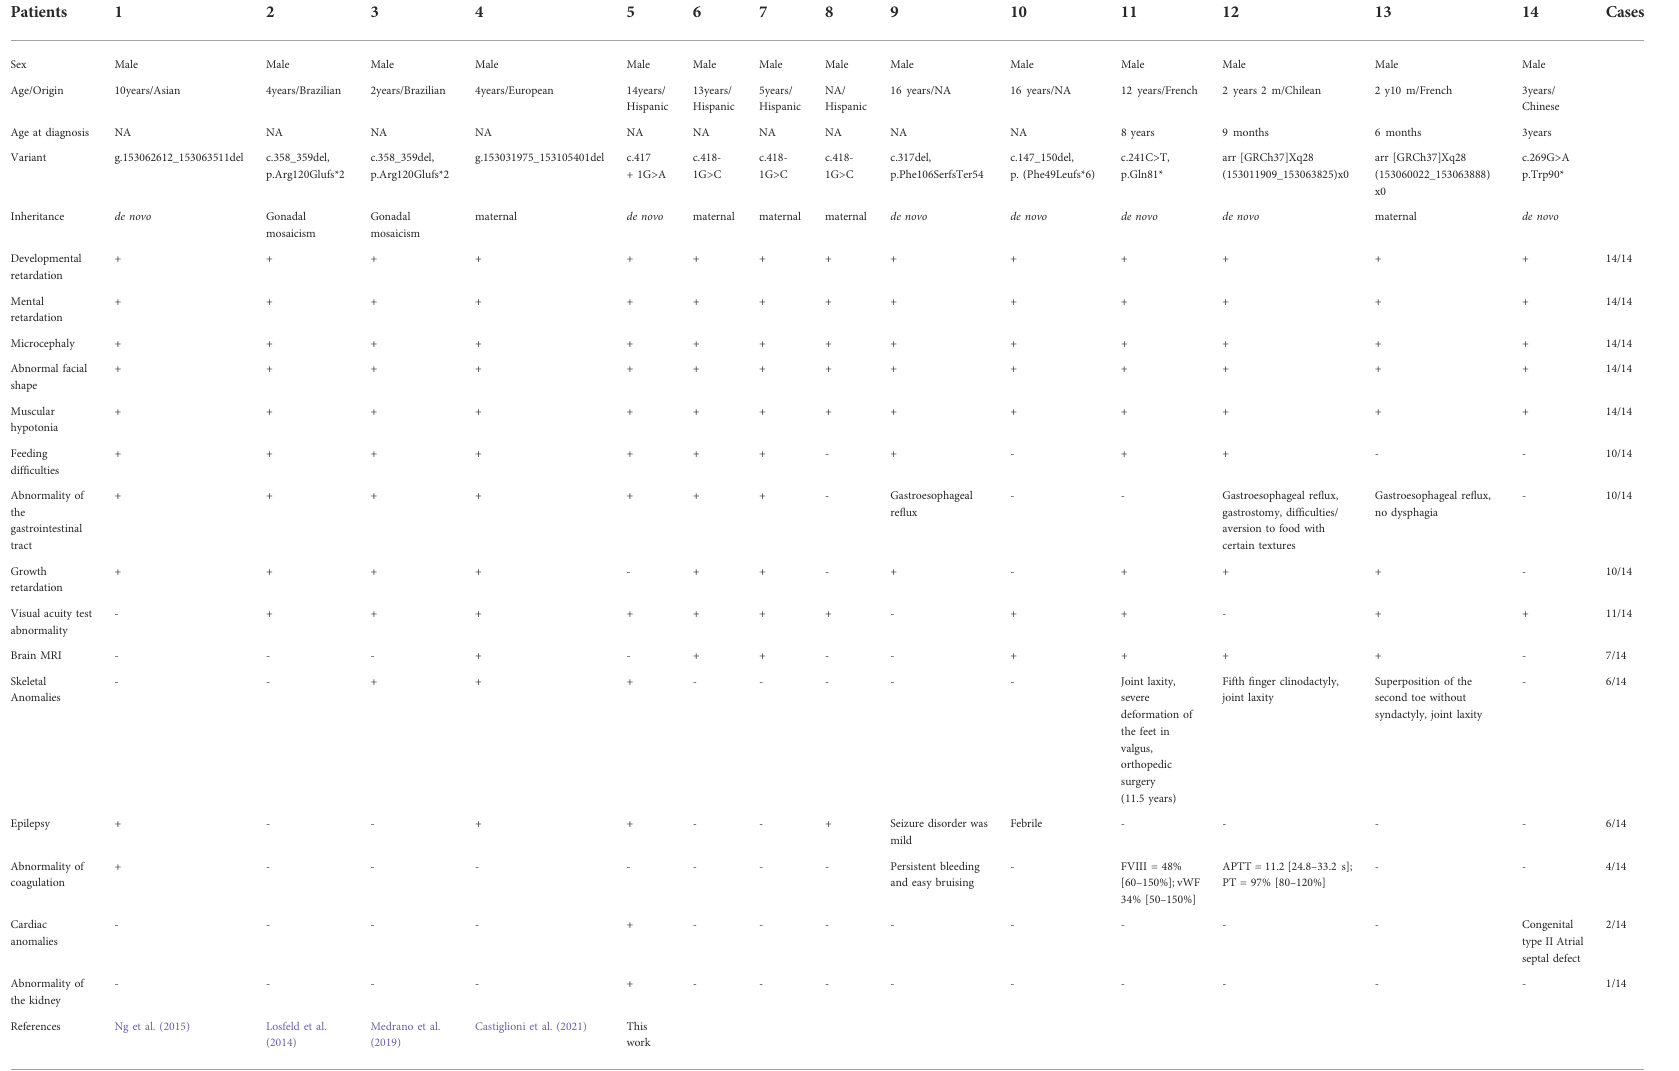
TABLE 1 The clinical fi ndings and the variants in the 14 children with X-linked SSR4-CDG.